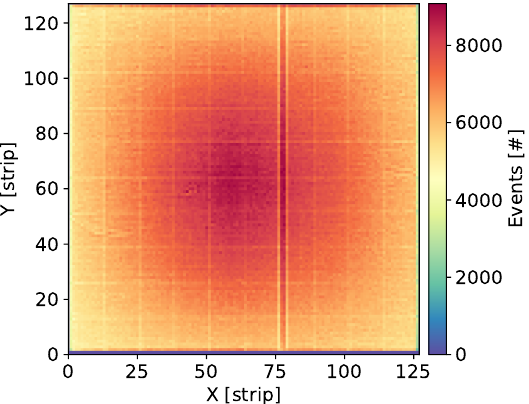
Figure 3. GEM detector A 2 . Map of cumulative counts of reconstructed events for detector bias voltage of